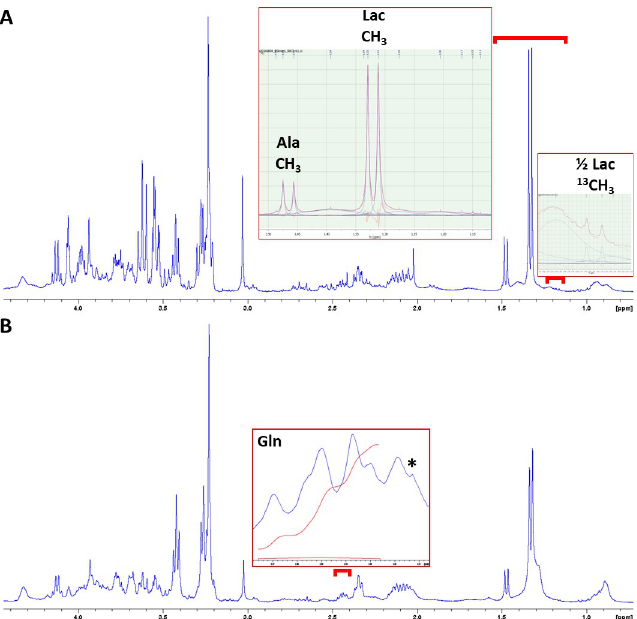
Fig 3. Initial 1 H-CPMG spectra from brain and heart samples of the ACE group. Representative examples from the same animal subject, to display the quantification procedures for brain lactate ( A ) and heart glutamine ( B ). The CMPG filter did not fully saturate the lipid-macromolecule contributions to the spectral pattern, which were thus included in the 1.54–1.14 ppm deconvolution procedure (along with alanine CH 3 ) for brain lactate quantification, both unlabeled (CH 3 doublet, 1.32 ppm) and labeled satellite pools (two 13 CH 3 doublets around the CH 3 doublet, with J-coupling 6.9 Hz–only quantified the one to the right, as displayed; the other one overlapping with Ala CH 3 ) ( A ). The quantification of glutamine, with a clear multiplet pattern in heart samples (2.45 ppm), was performed instead by baseline-corrected integration over a 2.48–2.42 ppm spectral window, to discard the singlet contribution of succinate at 2.41 ppm ( � ) ( B ).